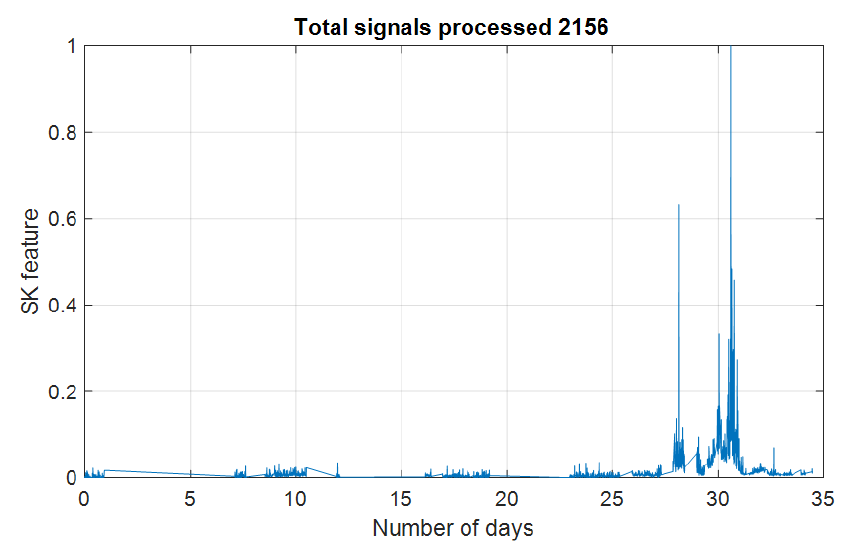
Figure 10. SK feature for all signals plotted against the number of days of testing.